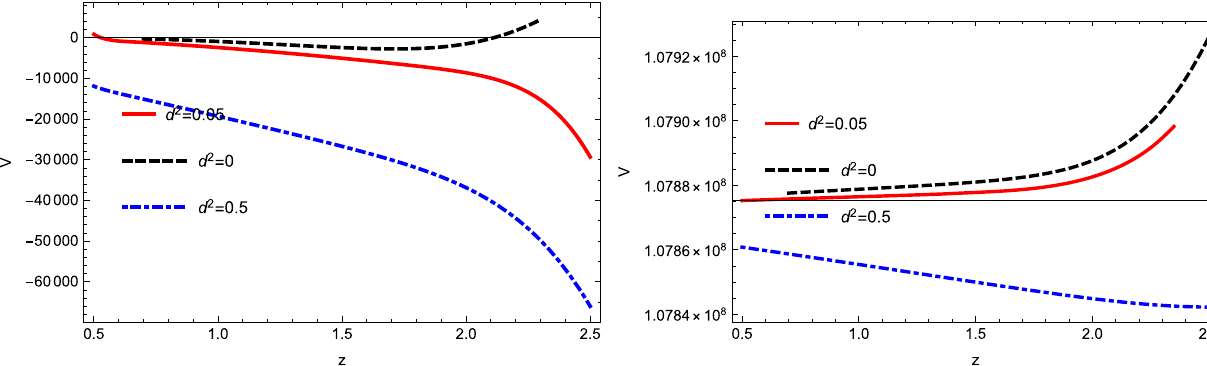
Fig. 35 Plot of V verses z for u = 1 and u = 2 . 002 for quintessence scalar field model